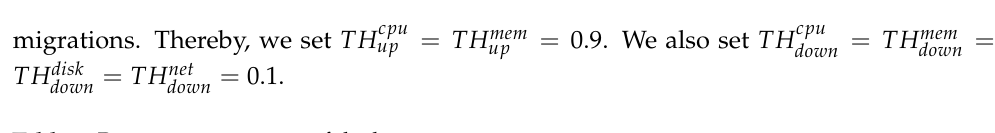
Table 1. Resource parameters of the hosts.